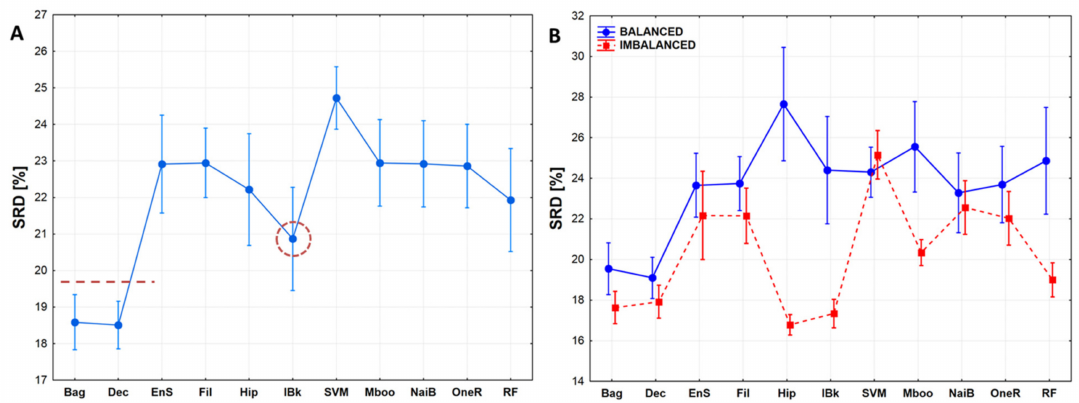
Figure 8. ( A ) Normalized SRD values for the eleven classifiers. Error bars mean 95% confidence intervals. Recommended classifiers are below the dotted line, dotted circle shows an intermediate one.